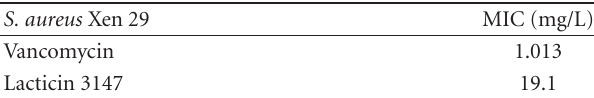
Table 1: The standard deviation in all cases is 0 reflecting identical triplicate